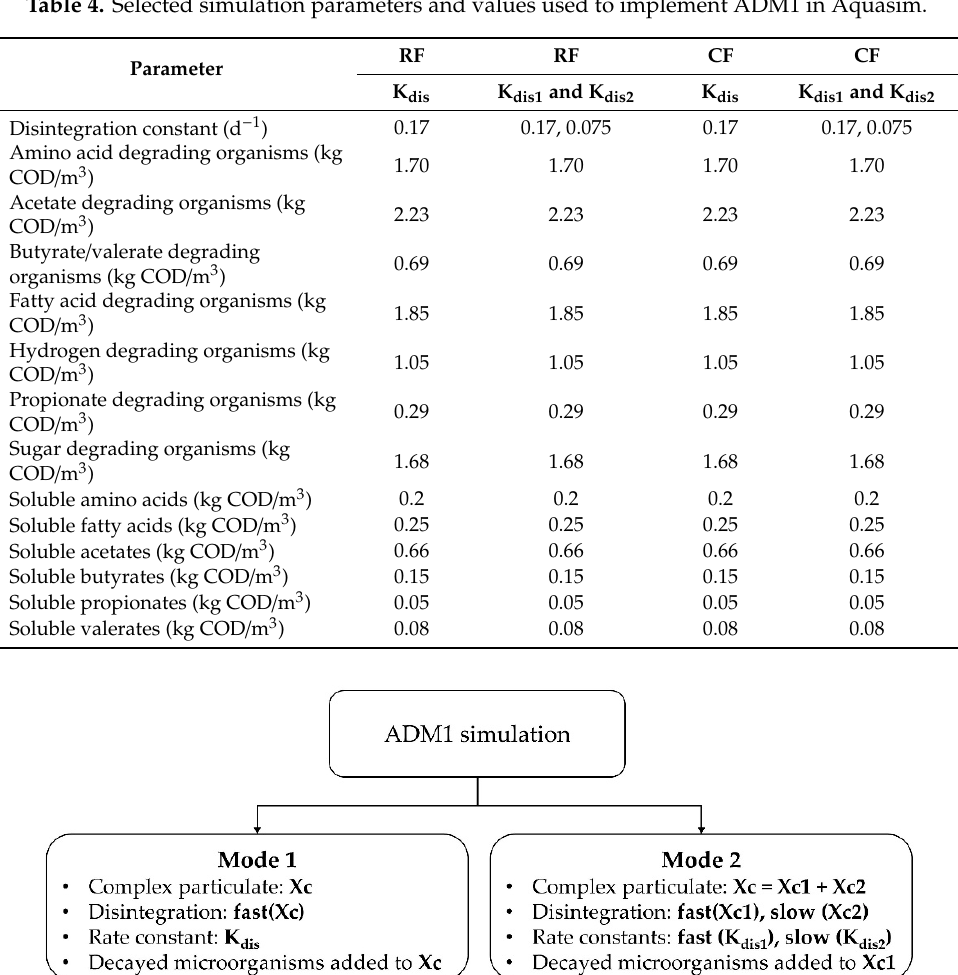
Figure 4. ADM1 simulation scheme for mode 1 and mode 2 simulations.